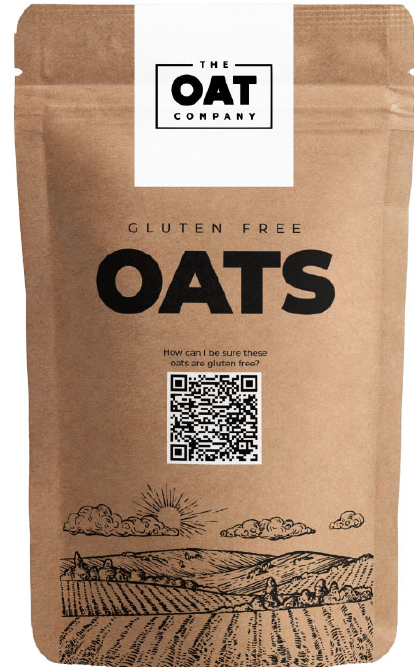
Figure 6: The QR code on the packaging of the oats, which opens the app showing public data, to prove their verified and assured gluten-free status